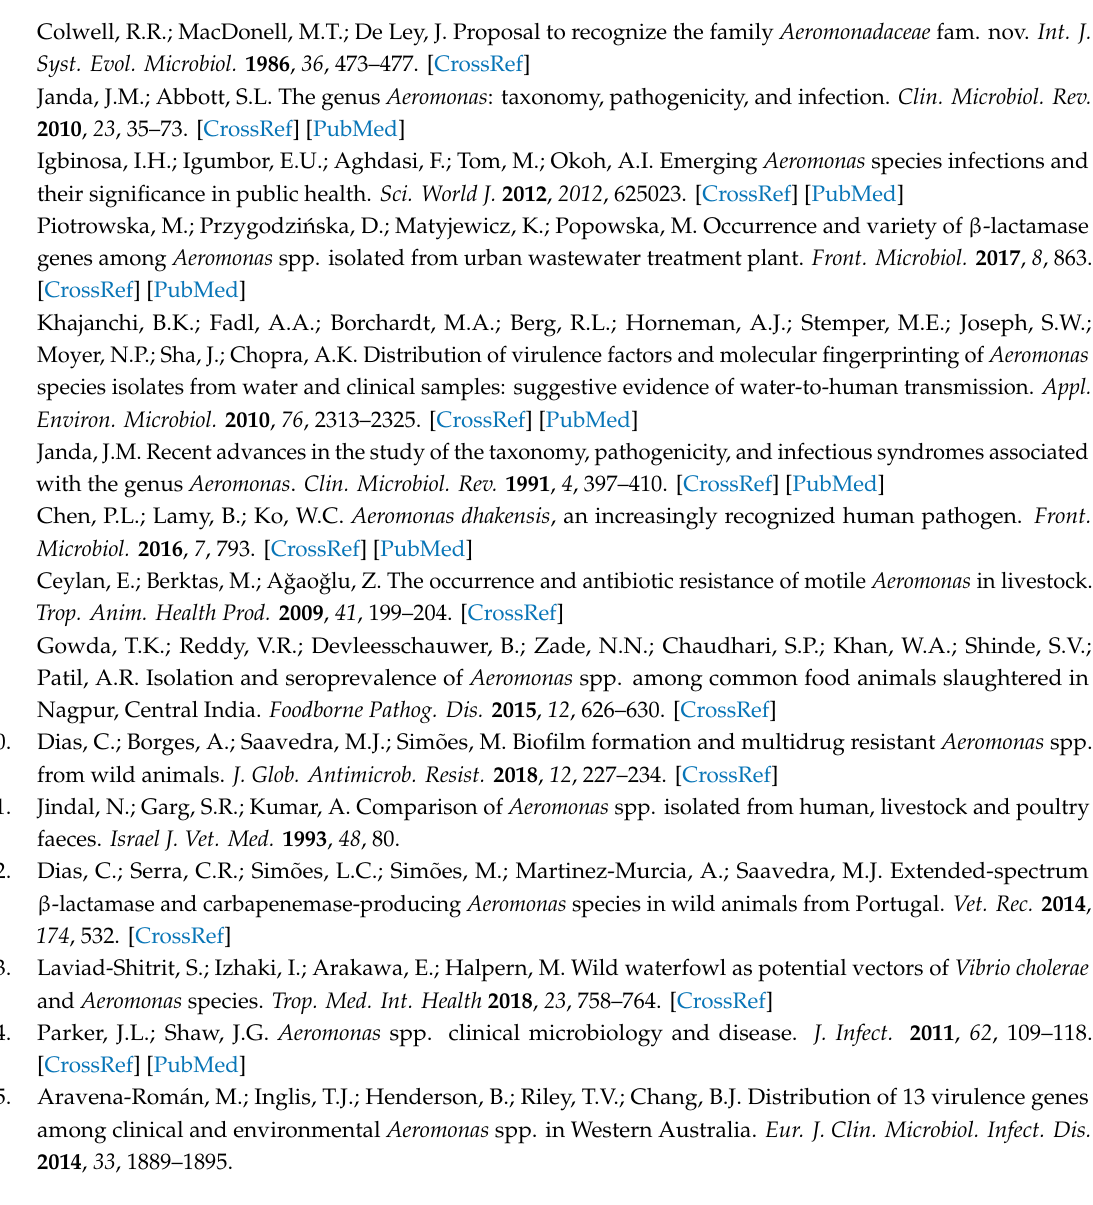
Table S1. List of PCR primers used in this study. Table S2. Biochemical characterization of Aeromonas spp. isolated in this study. Figure S1. Gel electropherogram of virulence-related gene amplicons from the 14 Aeromonas isolates used in this